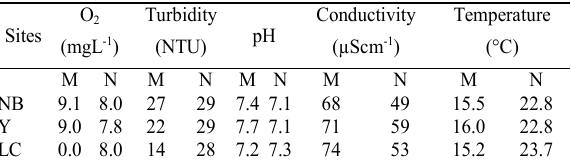
Table 1. Environmental characteristics of Uruguay River in Nuevo Berlín (NB), Yaguareté (Y) and Las Cañas (LC): dissolved oxygen (O ), turbidity, conductivity, pH, and 2 temperature during May (M) and November (N).